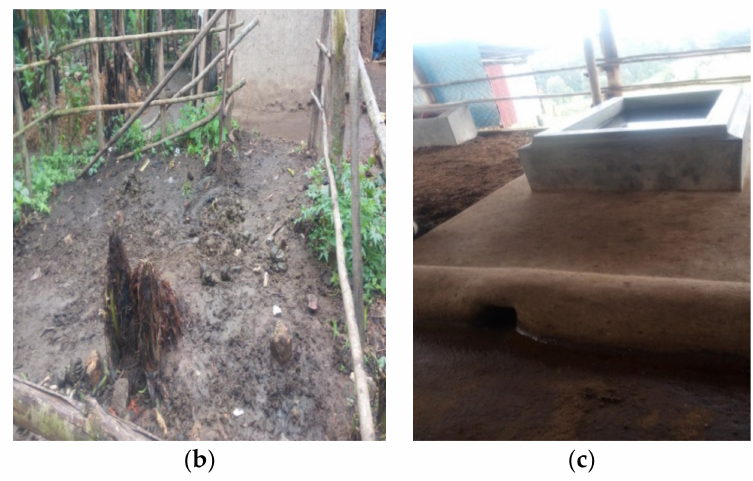
Figure 2. ( a ) Cow dung mixed with green grass and leaves, ( b ) Un-cemented kraal where cow dung mixes with soil and ( c ) Cemented kraal with minimal chances of cow dung mixing with soil.